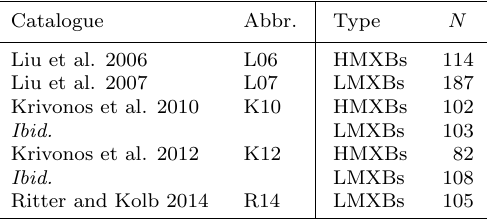
Table 1. Catalogues of X-ray